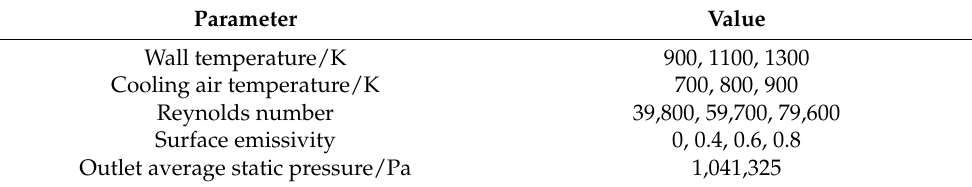
Table 3. Values of